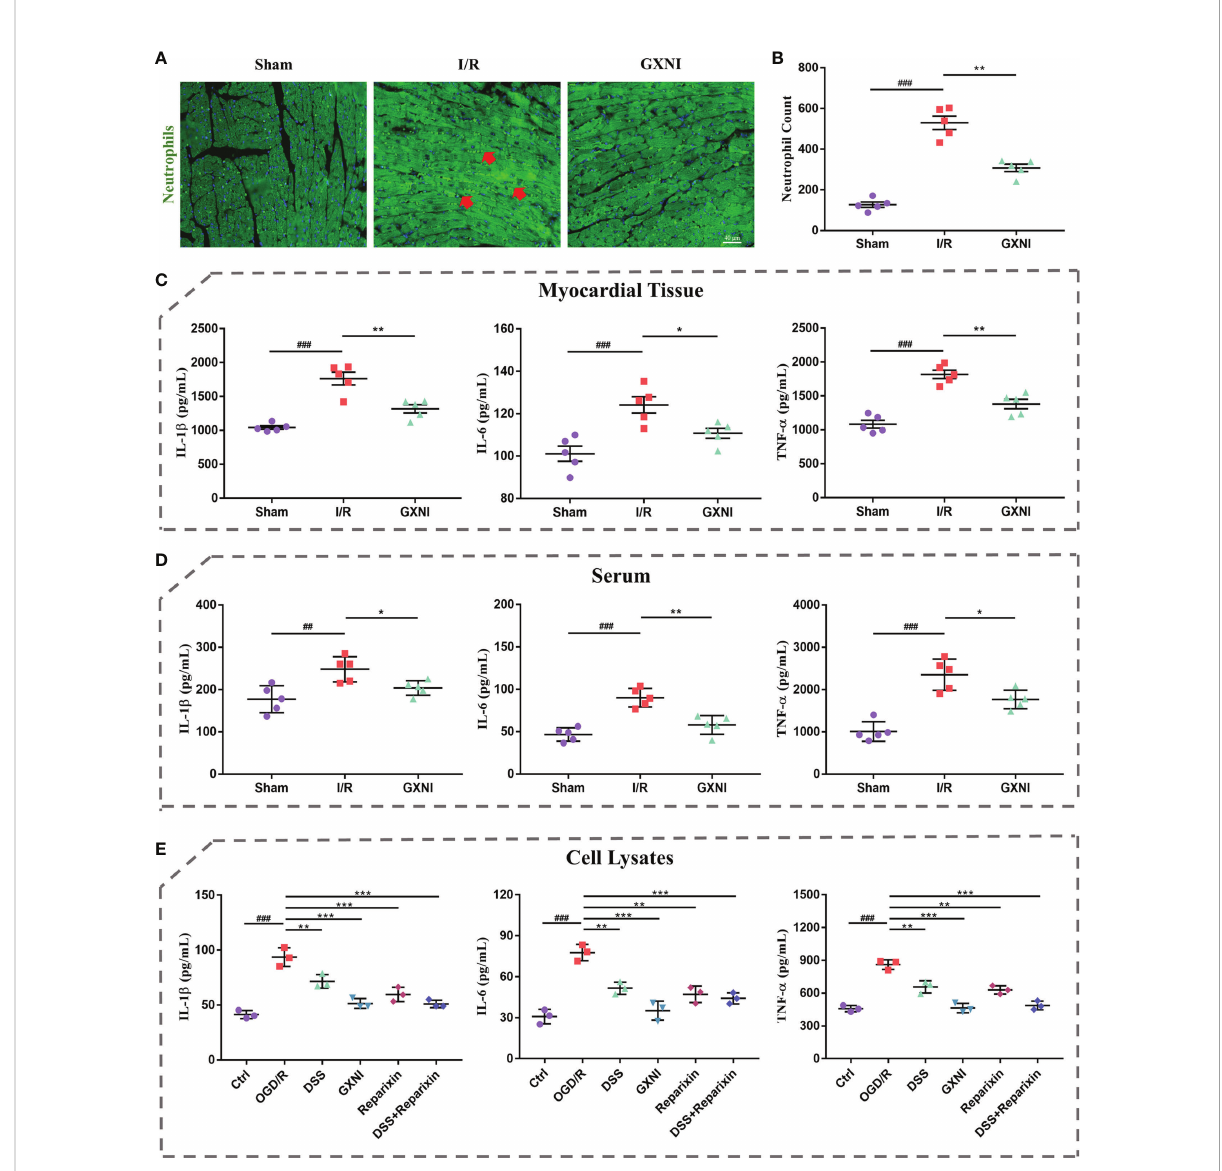
FIGURE 7 GXNI and DSS inhibited excessive release of in fl ammatory factors and leukocyte in fi ltration induced by I/R or OGD/R. (A) Representative images of immunohisto fl uorescence staining of mouse myocardium tissue in the sham, I/R, and GXNI (9 mL/kg) groups. The nuclei were stained in blue, while neutrophils were in green. (B) Quanti fi cation of neutrophil numbers in the sham, I/R and GXNI (9 mL/kg) groups. (C) The expression levels of IL-1 b , IL-6 and TNF- a in the supernatant of myocardial tissue of mice in the sham, I/R and GXNI (9 mL/kg) groups. (D) The expression levels of IL-1 b , IL-6 and TNF- a in the serum of mice in the sham, I/R and GXNI (9 mL/kg) groups. Values were expressed as mean ± SEM (n = 5). ## P < 0.01, ### P < 0.001 vs. Sham group, * P < 0.05, ** P < 0.01 vs. I/R group. Scale bar = 40 µm. (E) Quantitation of the expression levels of IL- 1 b , IL-6 and TNF- a in cell lysates of each group in in vitro experiments. Values were expressed as mean ± SD (n = 3). ### P < 0.001 vs. Ctrl group; ** P < 0.01, *** P < 0.001 vs. OGD/R